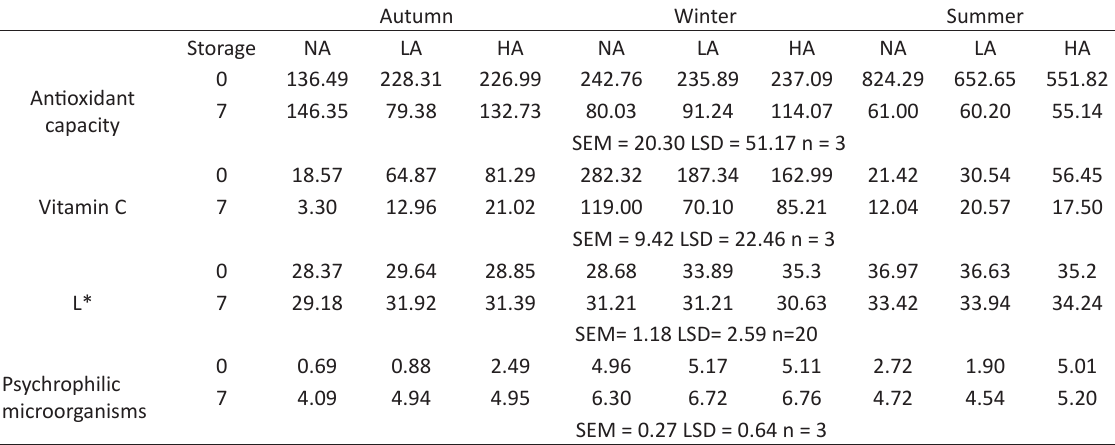
Table 3. Interaction (cycle x aeration x storage time) in the parameters of antioxidant capacity, vitamin C, lightness (L*) and psychrophilic microorganisms of red lettuce cultivated in floating system, with different levels of aeration of the nutrient solution (no aeration -NA-, low aeration -LA-, high aeration -HA-) in three growing cycles (autumn, winter and summer), stored at 5 °C for up to 7 days Autumn Winter